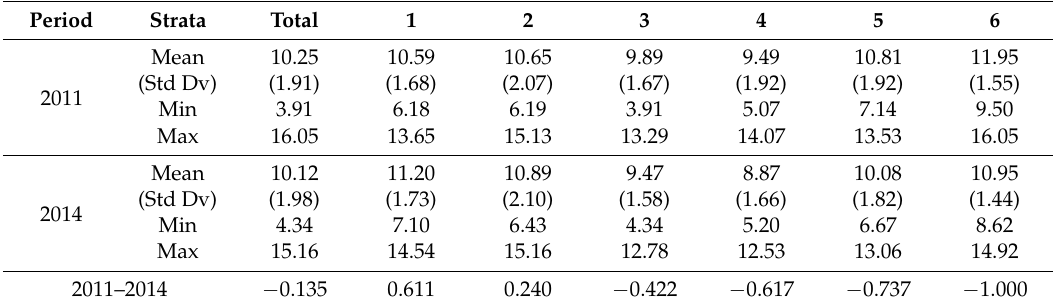
Table 2. Statistical description of mean consumption (m 3 /household/month) per unit.